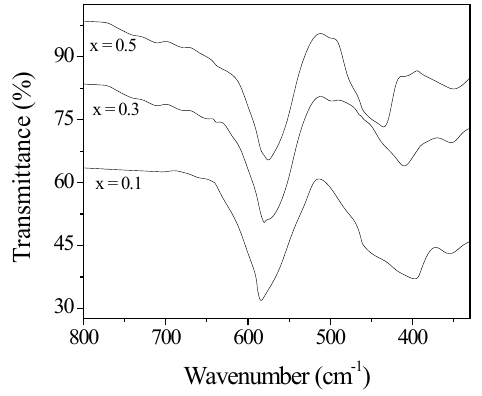
Figure 4. Infrared spectroscopy of typical samples x = 0.1, 0.3 and 0.5.